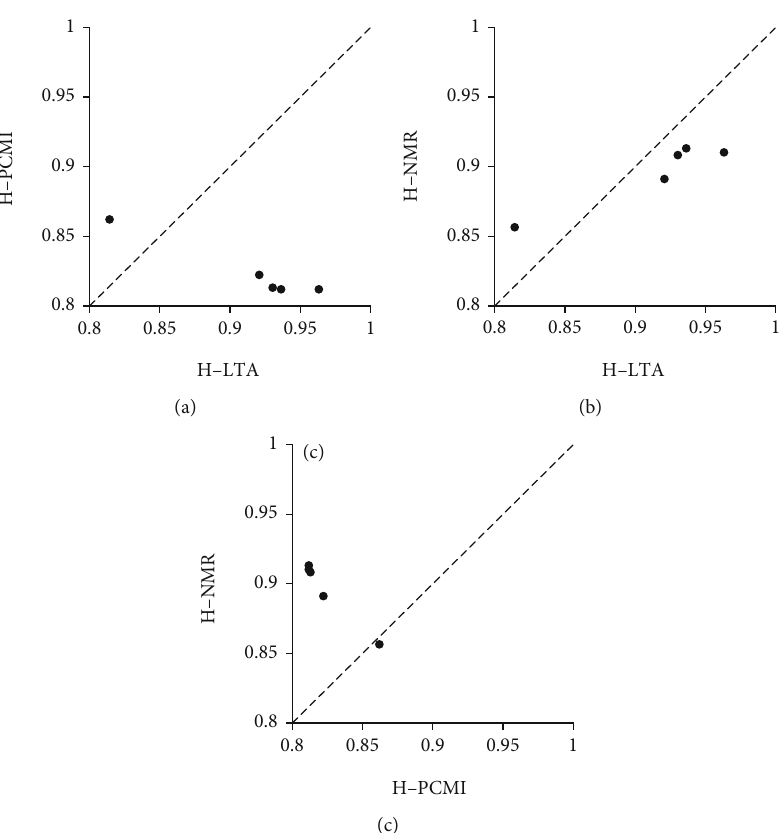
Figure 10: The comparison of Hurst exponent between (a) LTA and PCMI; (b) LTA and NMR; (c) PCMI and